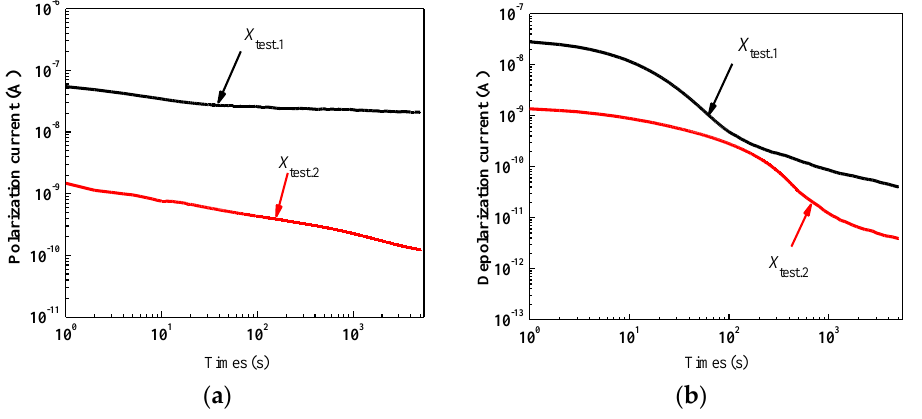
Figure 8. PDC results of the test samples. ( a ) X test.1 ( b ) X test.2 .